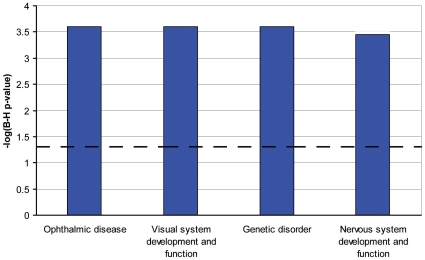
Four most significant biological functions identified by Ingenuity software [25] in the group of RPE-specific genes.The four bars represent the canonical pathway identified, the x-axis identifies the pathways. The y-axis shows the −log of the Benjamini-Hochberg (B–H) p-value. The dotted line represents the threshold above which there are statistically significantly more genes in a pathway than expected by chance.